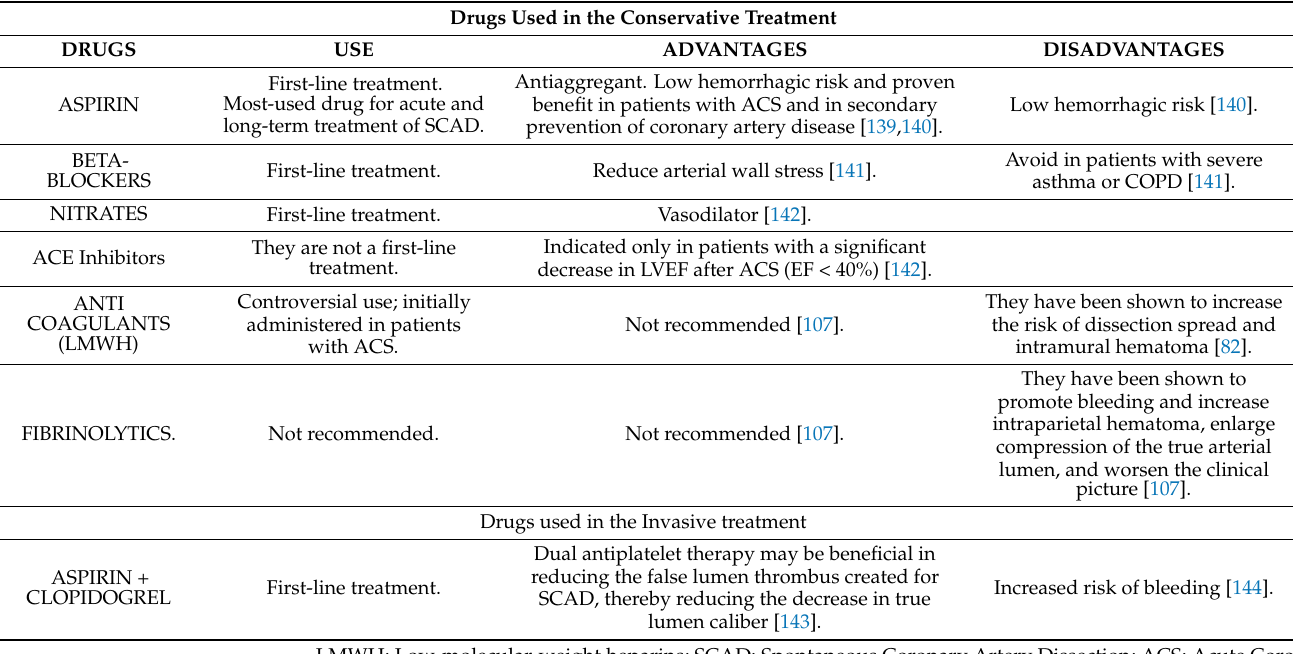
Table 1. Use of drugs in the treatment of SCAD. Drugs Used in the Conservative